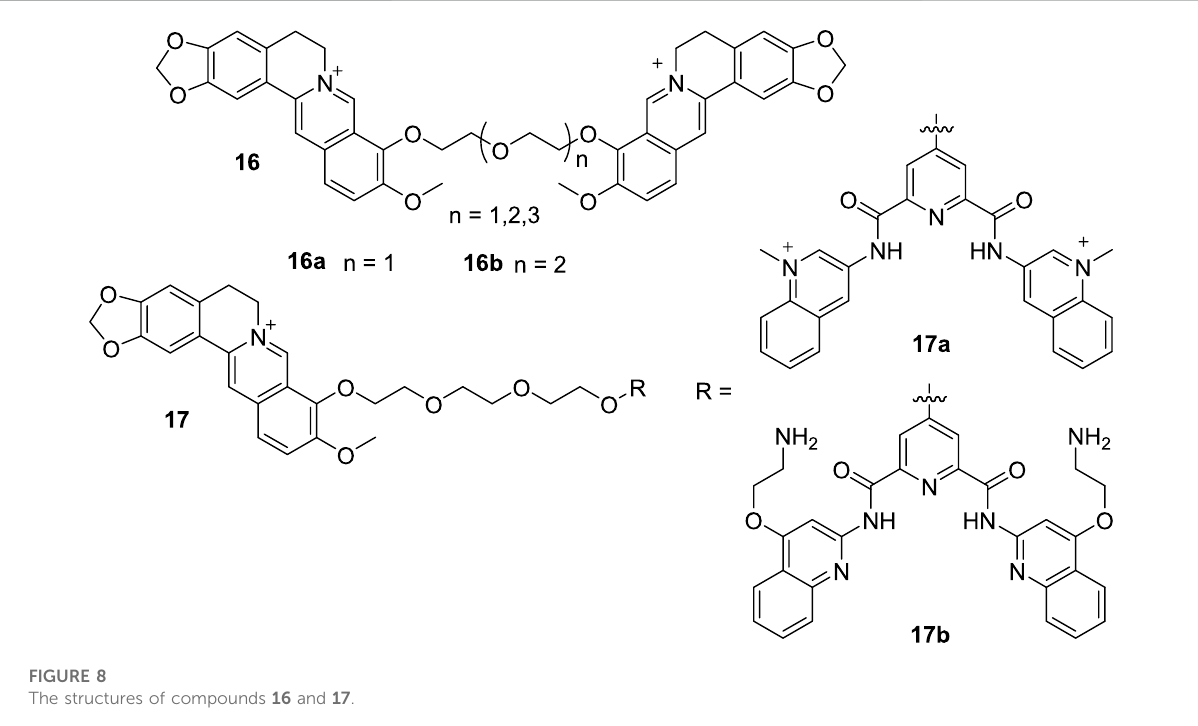
FIGURE 8 The structures of compounds 16 and 17